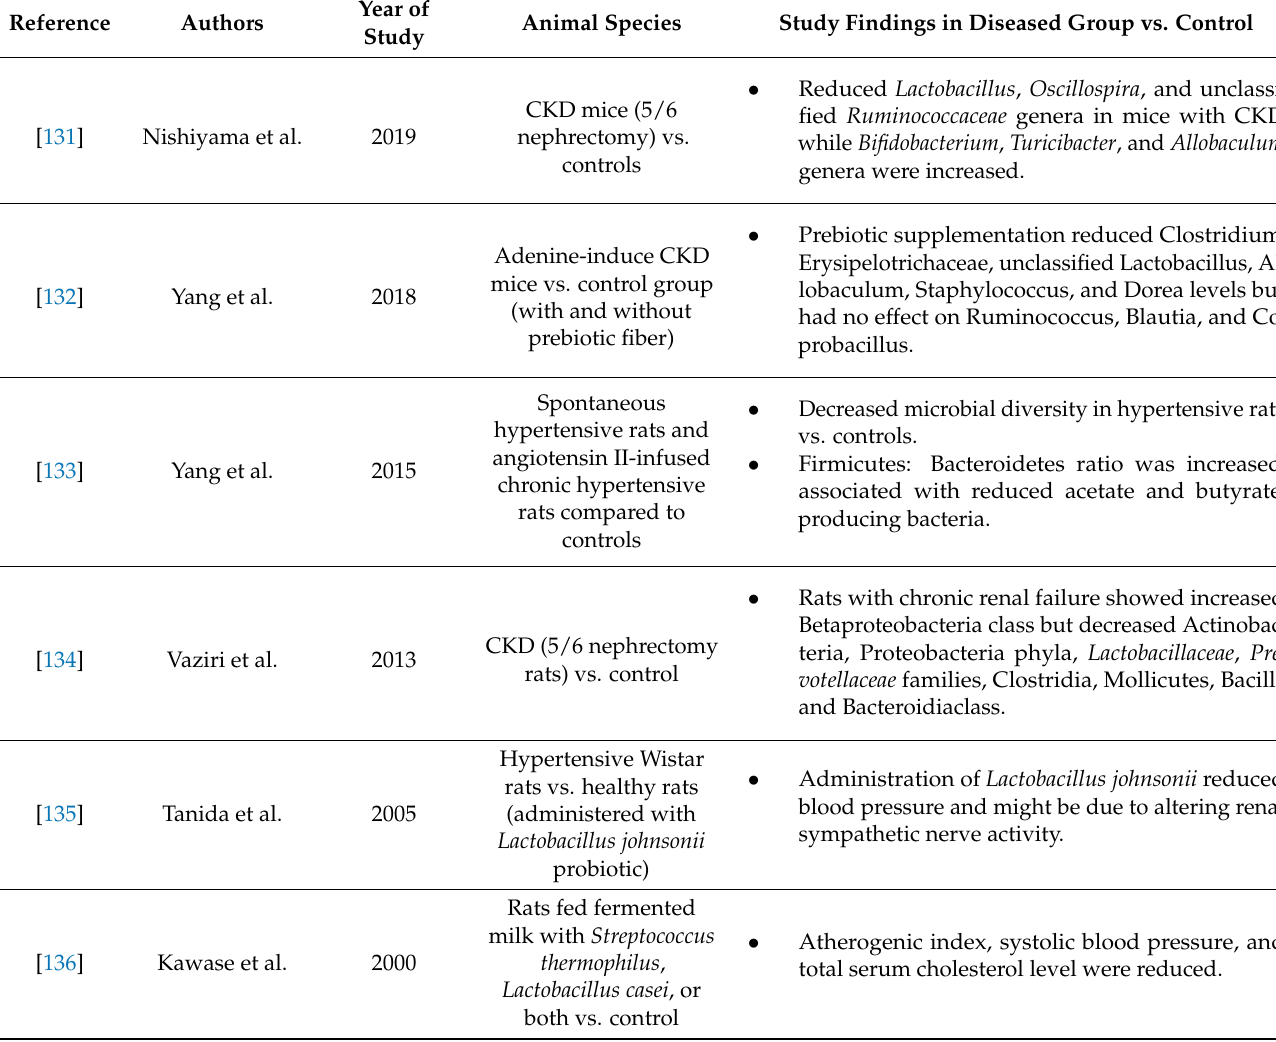
Table 7. Animal studies of the gut microbiota in